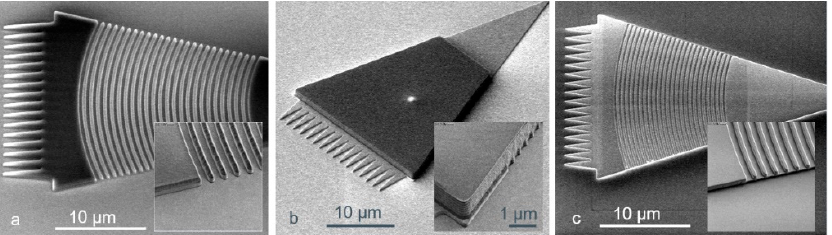
Figure 11. Grating coupler fabrication by a two-step silicon etching. ( a ) The first Si etching. Inset: the hard mask (SiO2) on top of the 70 nm Si patterns. ( b ) Lithography of the second Si etching. Inset: the photoresist mask for second Si etching. ( c ) The second Si etching. Inset: two-steps Si structure.